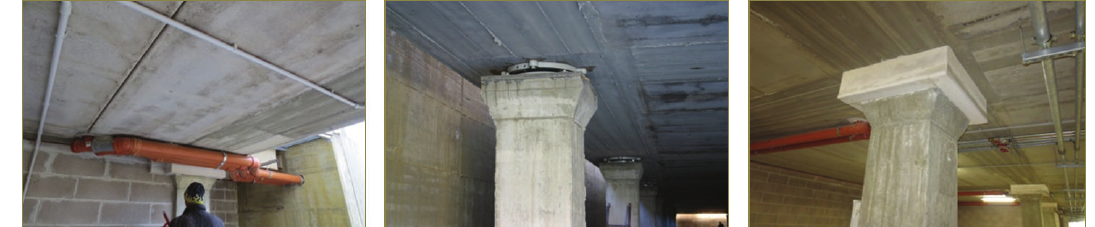
Figure 17: Images of waste water pipes at an interface area between the mobile and fixed portions of the building and two columns before and after the installation of the fire-protection plasterboard on the isolators.